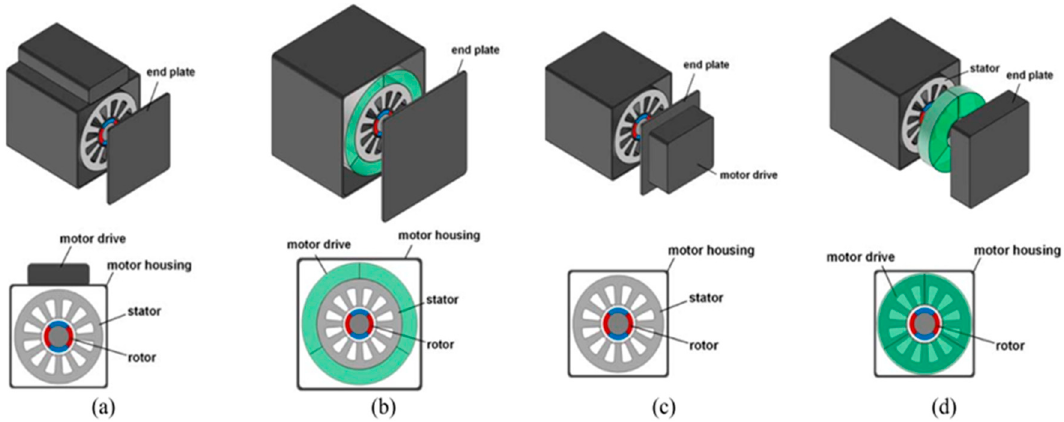
Figure 34. Conceptual illustration of four different IMD configurations: ( a ) RHM; ( b ) RSM; ( c ) AHM; and ( d ) ASM [15].